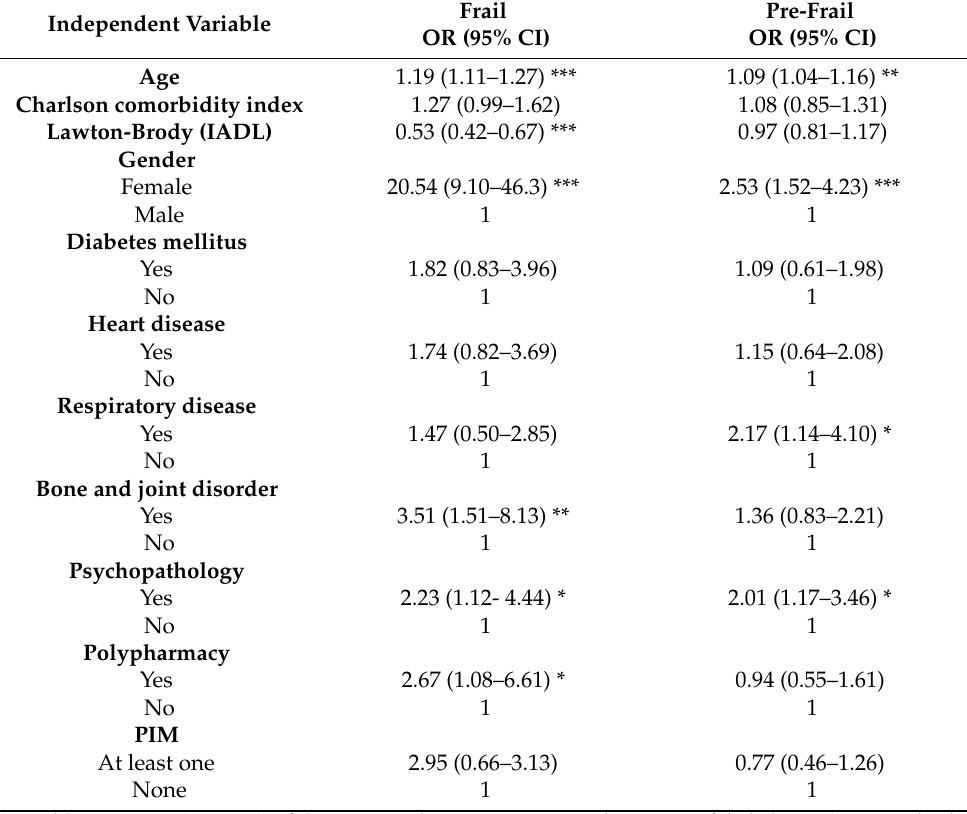
Table 3. Factors related to frailty. Multinomial logistic regression for frail and pre-frail states (with respect to